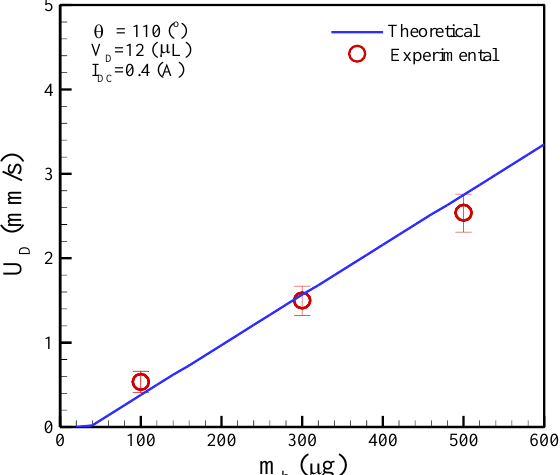
Figure 10. Moving speed of a droplet versus the loading mass of the magnetic beads, where ζ = 0.001 was chosen in this case.